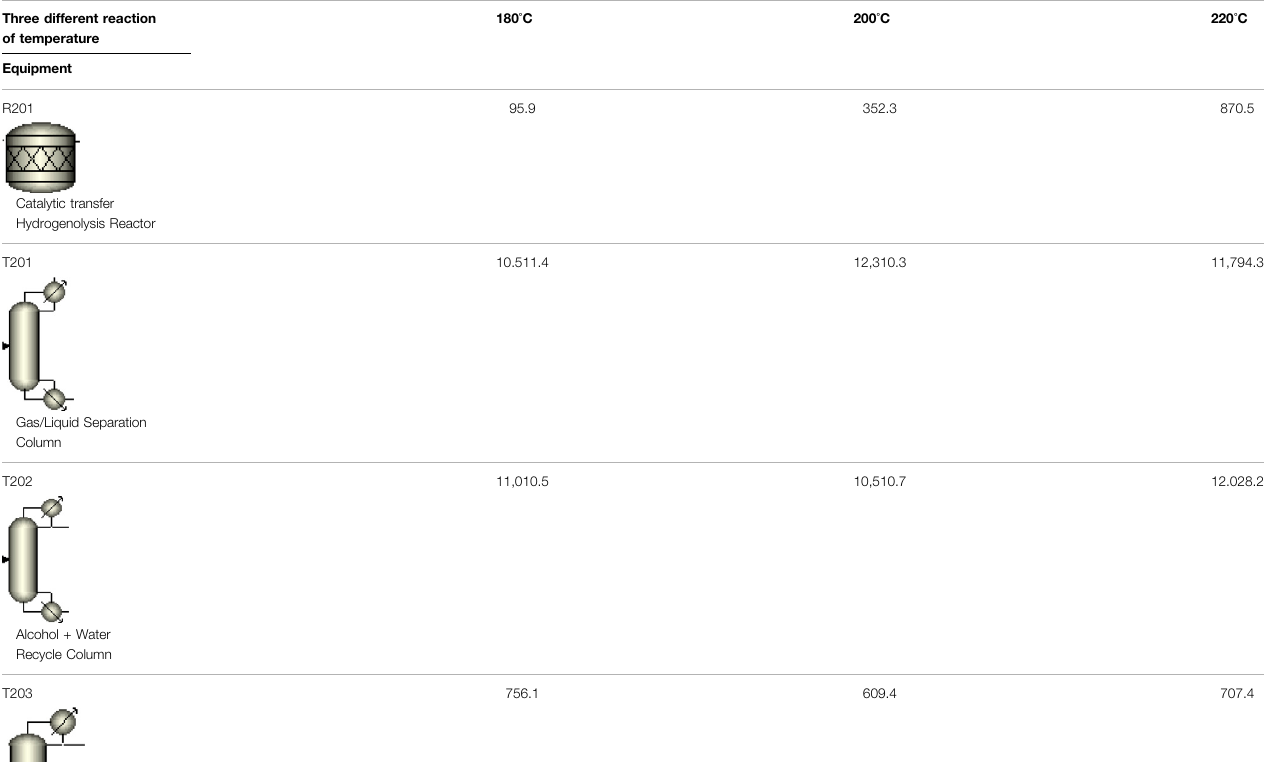
TABLE 3 | Energy consumption of main equipment in CTH process at different concentration of